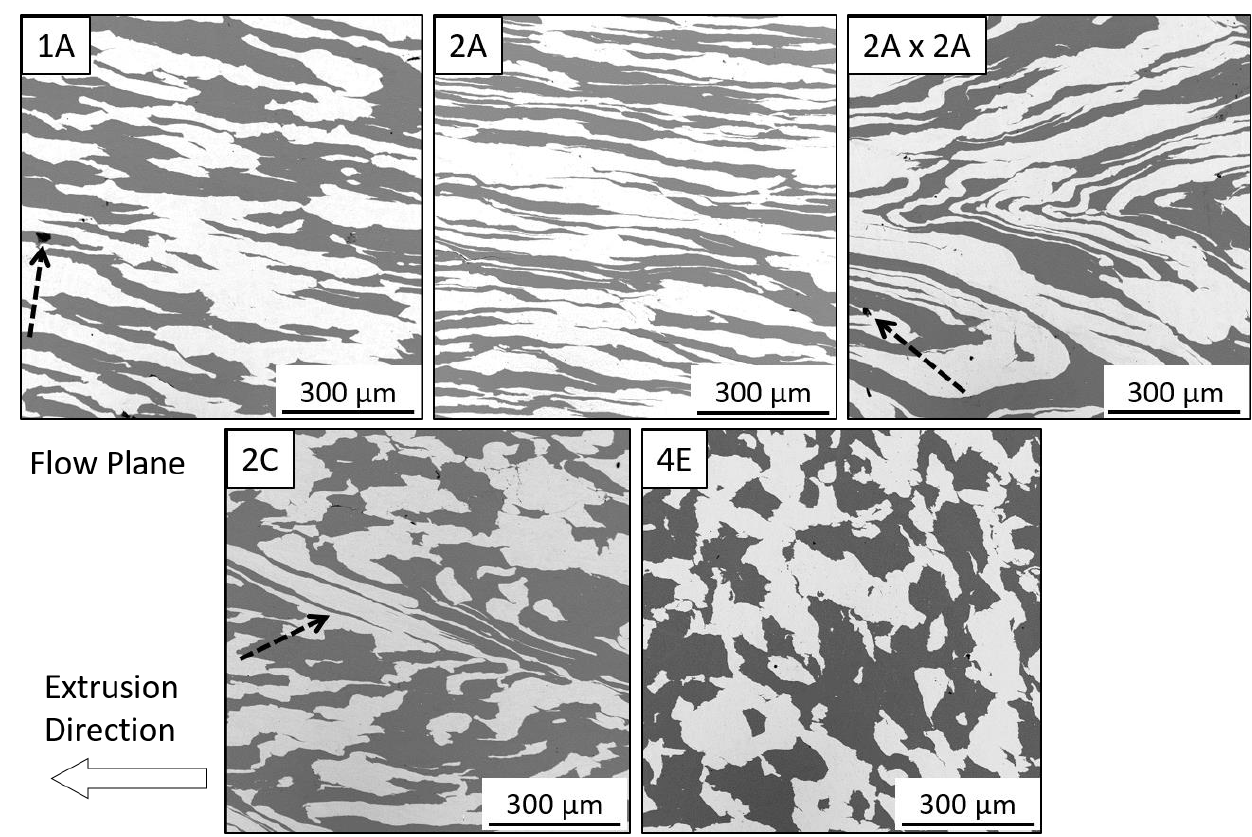
Figure 2. Micrographs on the Flow plane of Cu-Ta composites consolidated at ambient temperature by ECAE routes 1A, 2A, 2A×2A, 2C, and 4E.